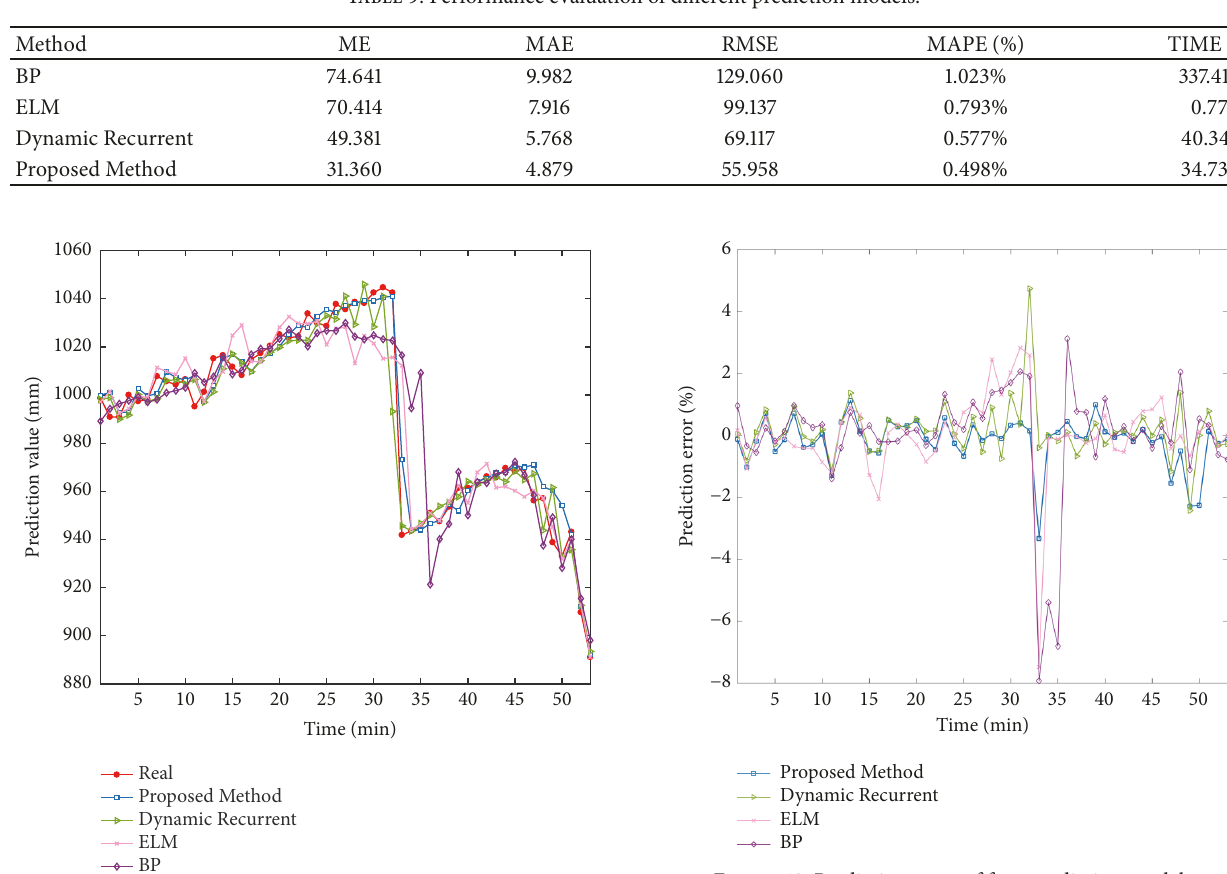
Figure 10: Prediction error of four prediction